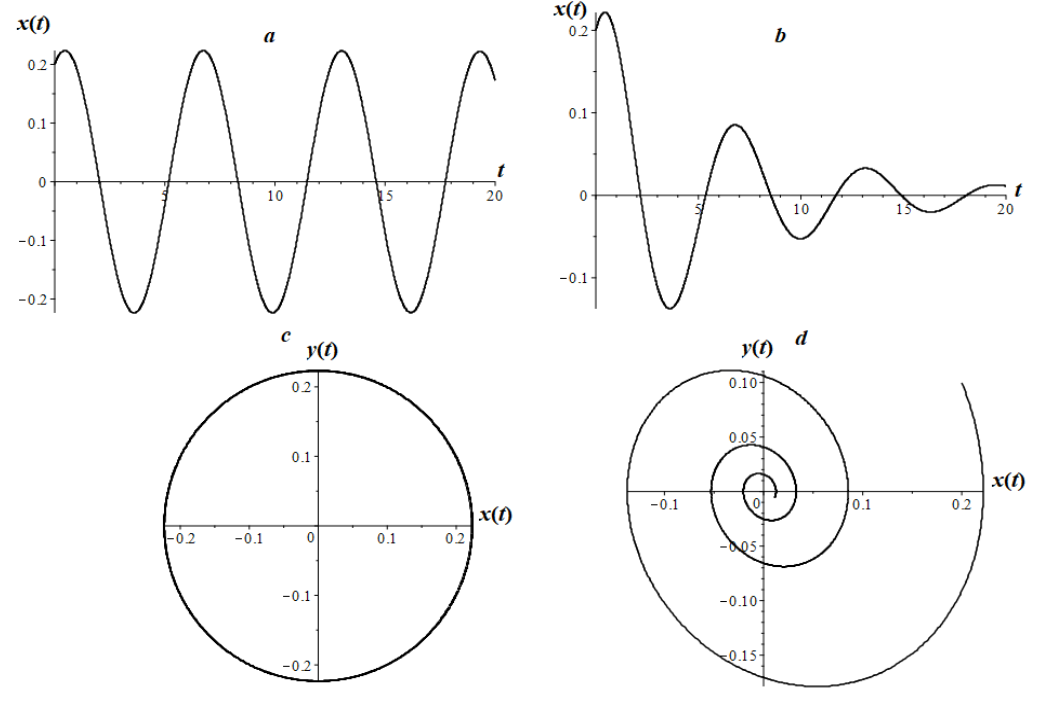
Figure 11. Harmonic oscillator ( β = 2, γ = 1) without friction: ( a )—oscillogram and ( c )—phase trajectory, as well as with friction: ( b )—oscillogram and ( d )—phase trajectory, in conditions of free